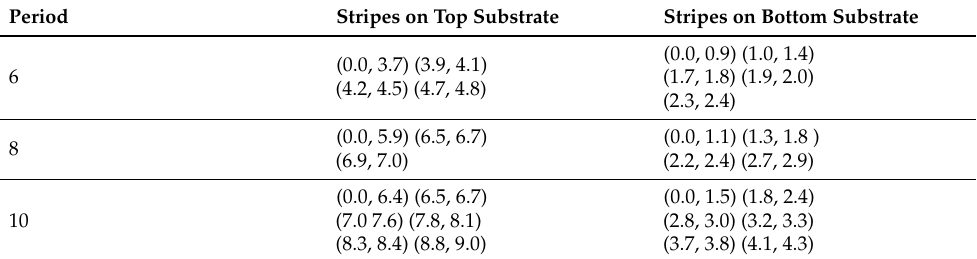
Table 1. Parameters of stripe patterns to be imprinted by FIB on both LC-cell substrates as obtained by the numerical optimization described in Section 2 for three metasurface periods. The stripe beginning and end x -coordinates are given together in parentheses. All values are in